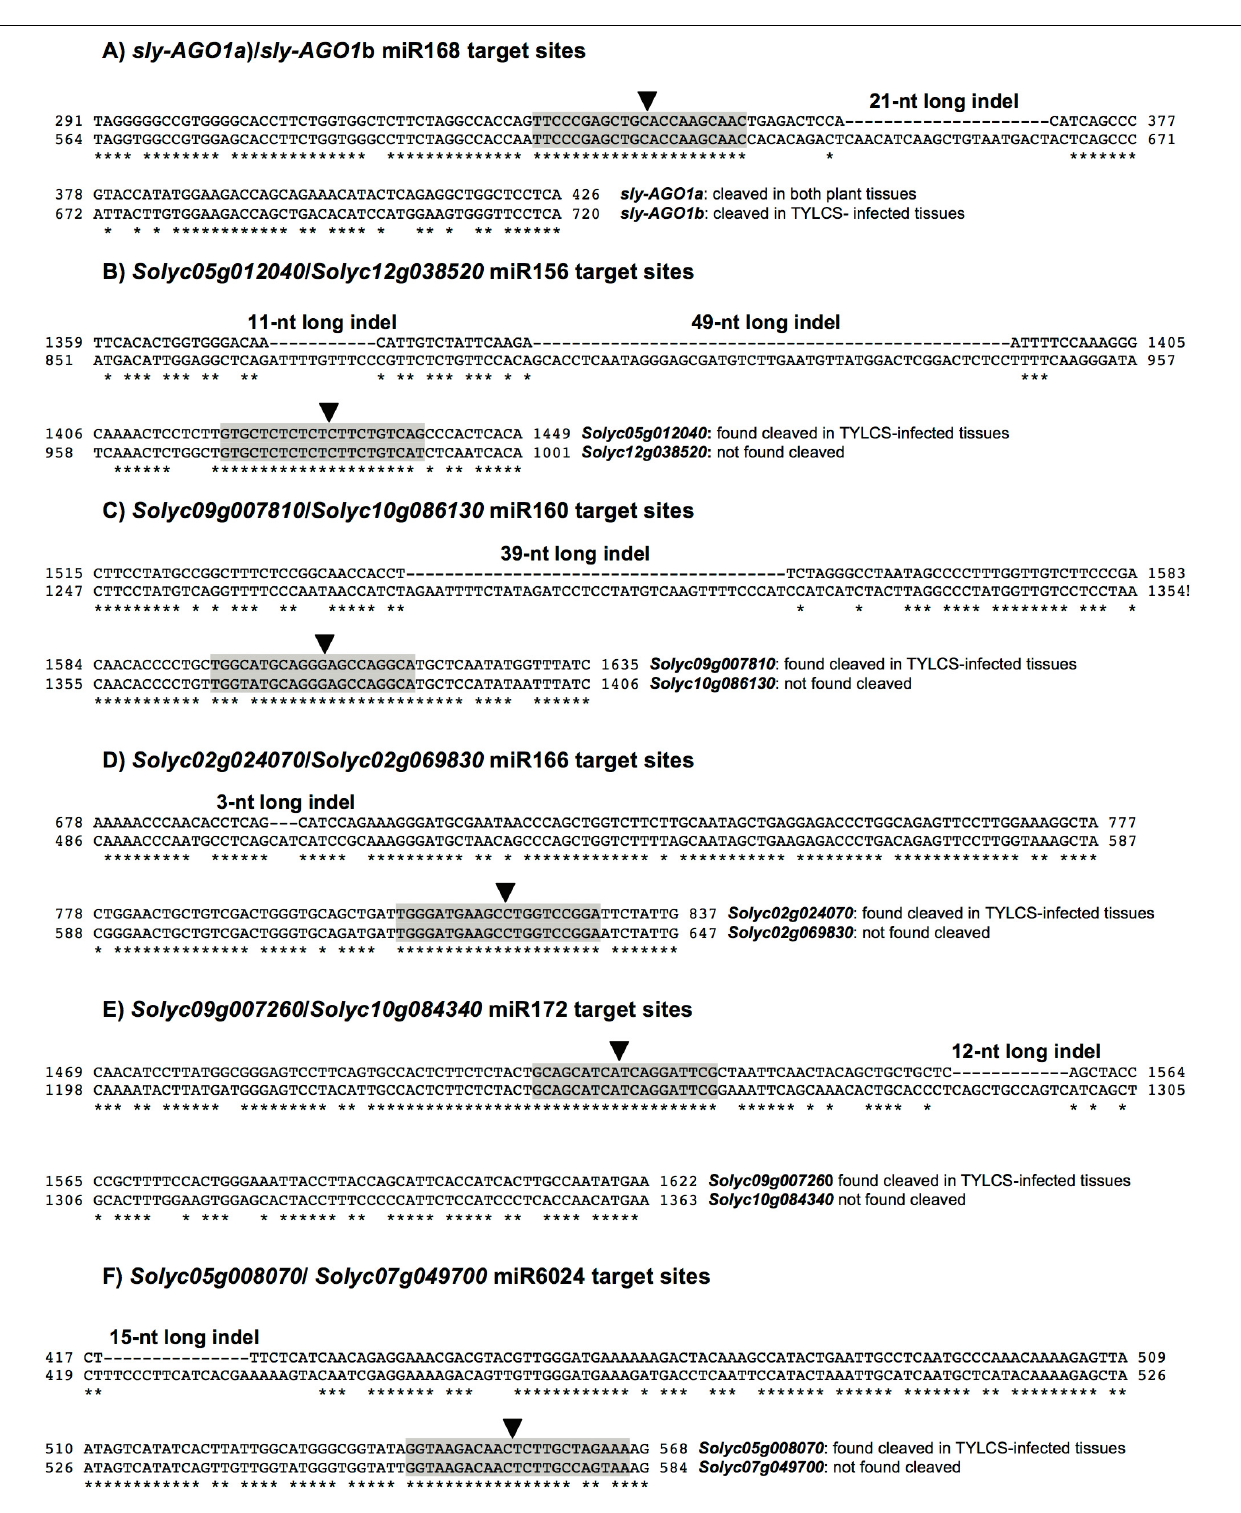
FIGURE 4 | Alignments of miRNA target sites and indels. Alignments of close paralogs in the miRNA target site vicinity showing the presence of short indels. Black arrows indicate the miRNA cleavage site found in the PARE analysis. (A) sly-AGO1a/sly-AGO1b alignment with respect to miR168 target site; (B) Solyc05g012040/Solyc12g038520 alignment with respect to miR156 target site; (C) Solyc09g007810/Solyc10g086130 alignment with respect to miR160 target site; (D) Solyc02g024070/Solyc02g069830 alignment with respect to miR166 target site; (E) Solyc09g007260/Solyc10g084340 alignment with respect to miR172 target site; and (F) Solyc05g008070/Solyc07g049700 alignment with respect to miR6024 target site.